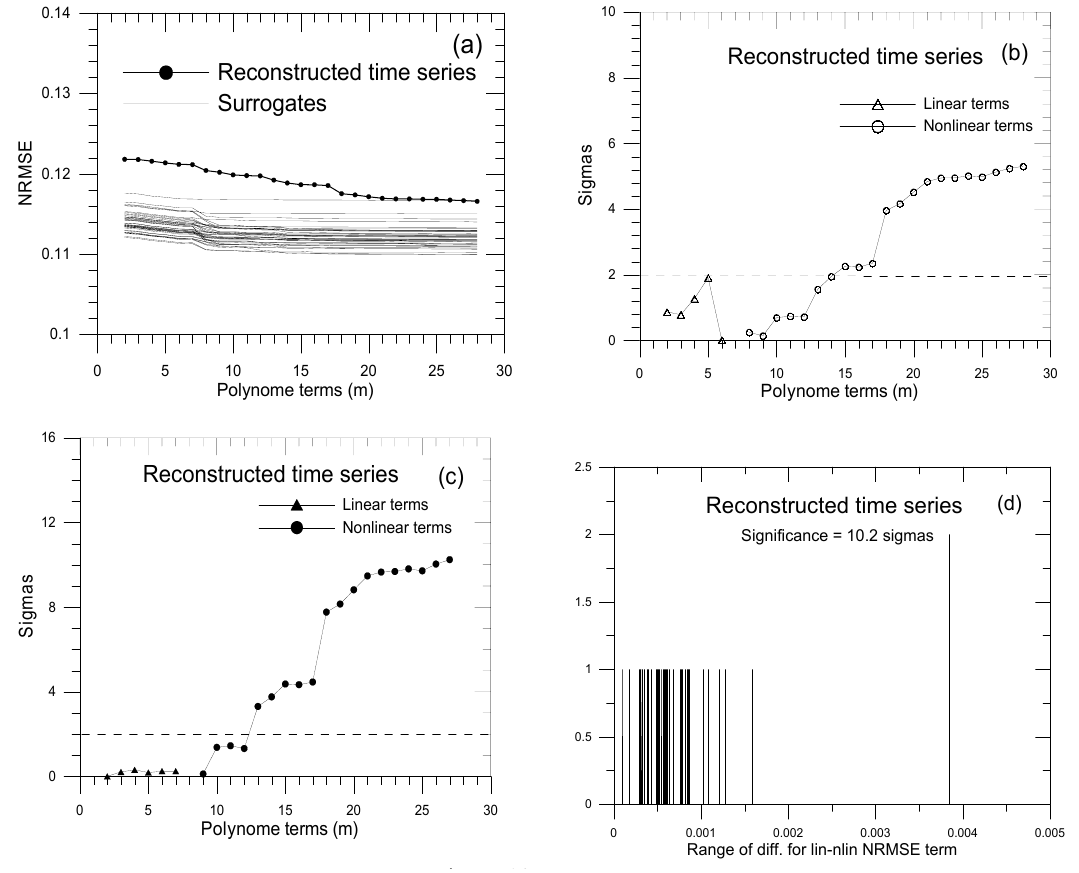
Fig. 10. (a) Normal root mean squares error (NRMSE) estimated by using a polynomial fitting for the reconstructed time series and its surrogate data, as a function of the polynomial terms, of the Voltera-Wiener estimated for parameters m = 6 ,t = 7 ,q = 2 and 1 step ahead mappings. (b) Significance of the reduction error statistic corresponding to the difference between the polynomial fitting of the first seven linear terms from the polynomial fitting containing all the possible linear-nonlinear terms. (c) Significance of the reduction error statistic between the polynomial fitting including the first nonlinear term (8th term) and the polynomial fitting containing all the possible linear-nonlinear terms. (d) The discriminating statistic of the reduction error for the energetic ions (tall line) and the surrogate data (short line), corresponding to the difference between the polynomial fitting including the first nonlinear term (8th term) from the polynomial fitting containing all the linear-nonlinear terms. Table 1. This table shows the significance of the estimated sttistics for the case of the largest Lyapunov exponent, the mutual information, the local linear prediction and the Voltera-Wiener modeling, for the ion time series, the first SVD component and the reconstructed